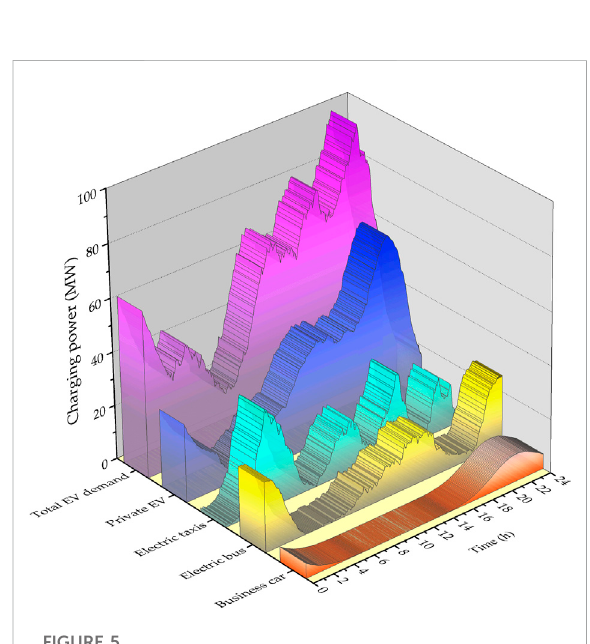
Figure 3. The newly generated population is used for the successive iterations of the algorithm until the stopping criteria of 500 total iterations.